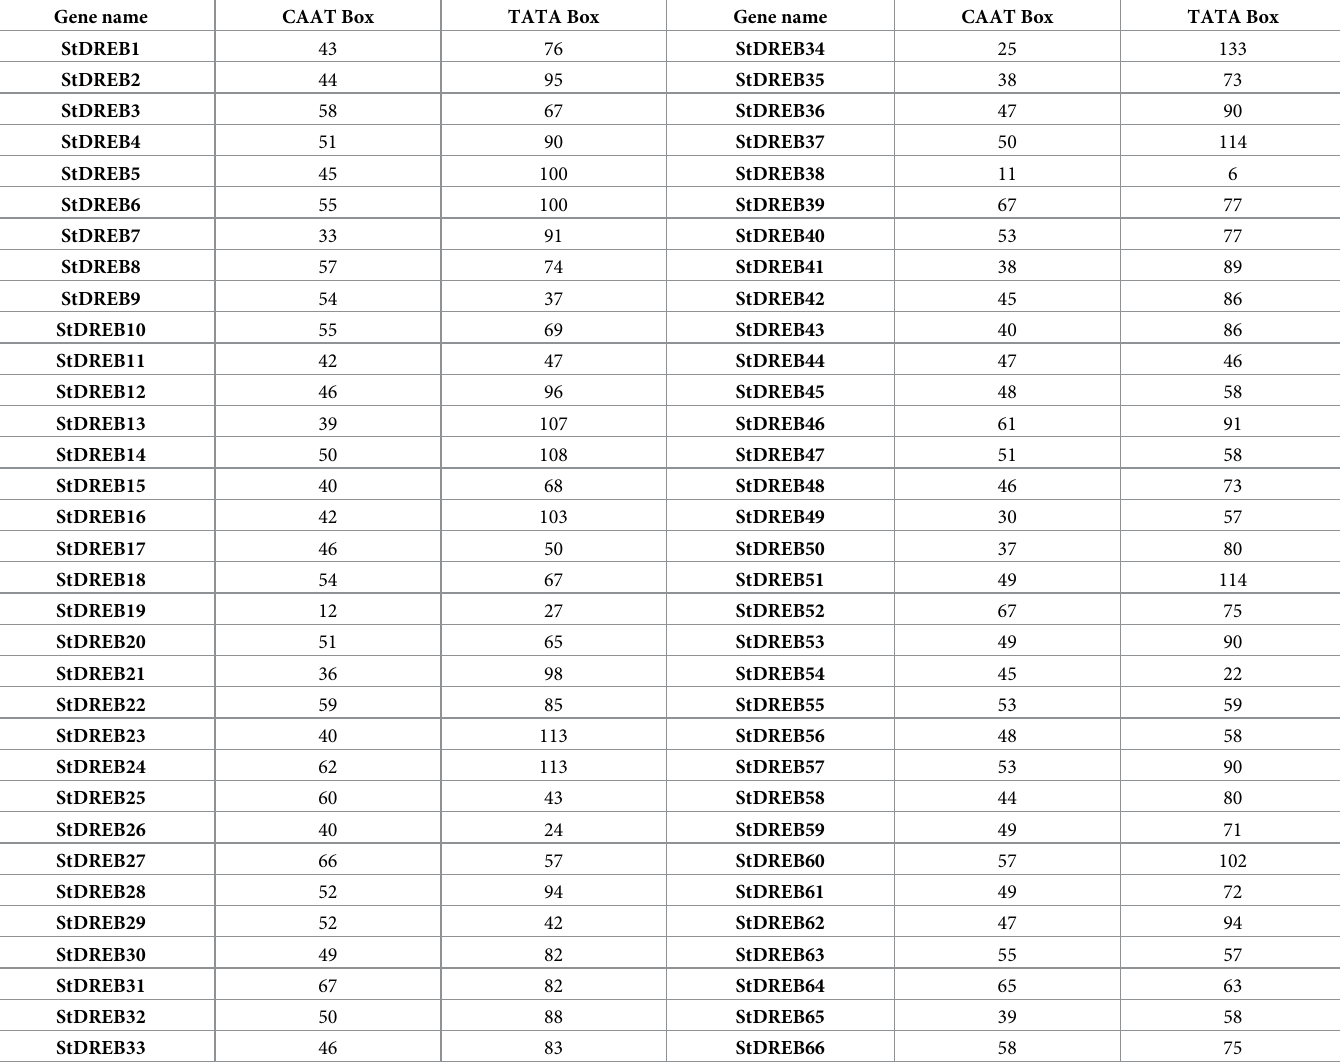
Table 1. Frequency of occurrence of CAAT-box and TATA-box in sixty-six (66) StDREB genes. Gene